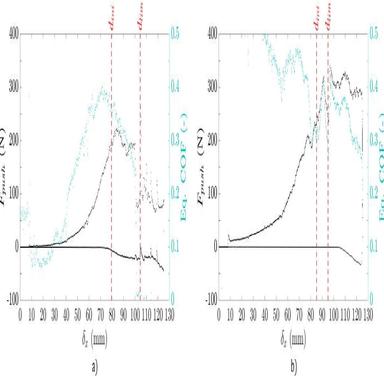
Load-displacement (left axis) and equivalent COF-displacement (right axis) curves for (a) rigid (T6-01) and (b) flexible (T7-03) adhesive samples, from the WDT+.